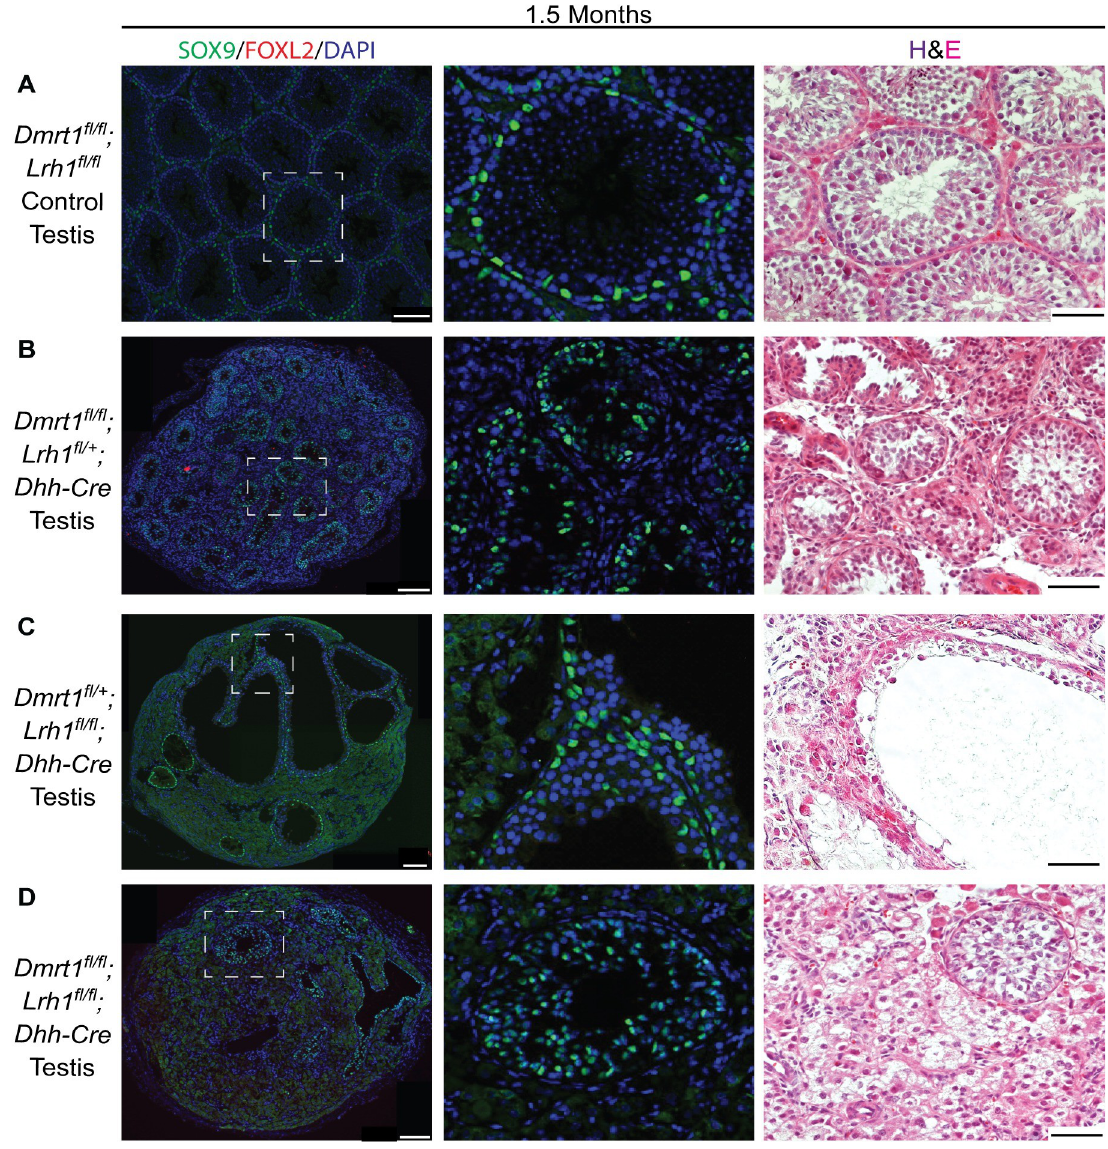
Fig 3. Lrh1 is required in Sertoli cells for seminiferous tubule morphogenesis and spermatogenesis. Immunofluorescence (IF) and hematoxylin/eosin (H&E) staining for 6 week old testes of indicated genotypes: (A) Control testis homozygous for floxed alleles of Dmrt1 and Lrh1 but lacking Cre ; (B) Mutant testis conditionally homozygous in Sertoli cells for Dmrt1 deletion and heterozygous for Lrh1 deletion; (C) Mutant testis conditionally heterozygous in Sertoli cells for Dmrt1 deletion and conditionally homozygous for Lrh1 deletion; (D) Mutant testis conditionally homozygous in Sertoli cells for both Dmrt1 and Lrh1 deletions. Dashed lines in left column indicate areas magnified in middle column. White scale bars: 100 um. Black scale bars: 50 um.